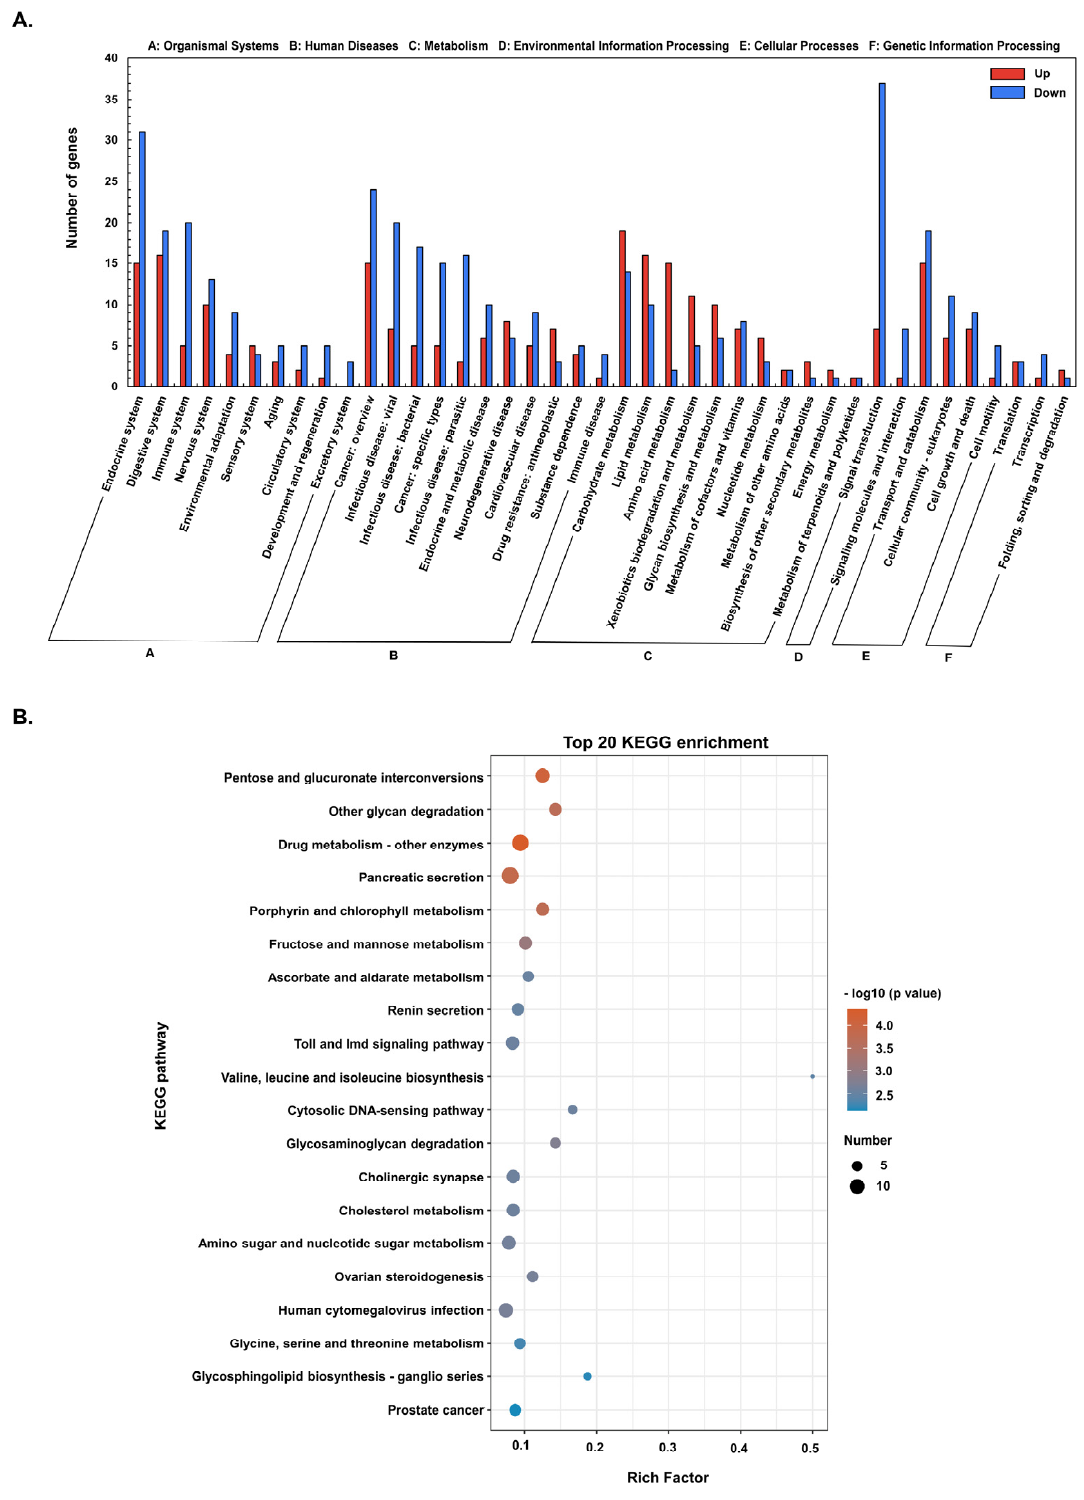
Figure 3. The Kyoto Encyclopedia of Genes and Genomes (KEGG) annotations and enrichment analysis of DEGs. ( A ) KEGG classification of upregulated and downregulated DEGs. ( B ) Top 20 KEGG enriched DEGs.